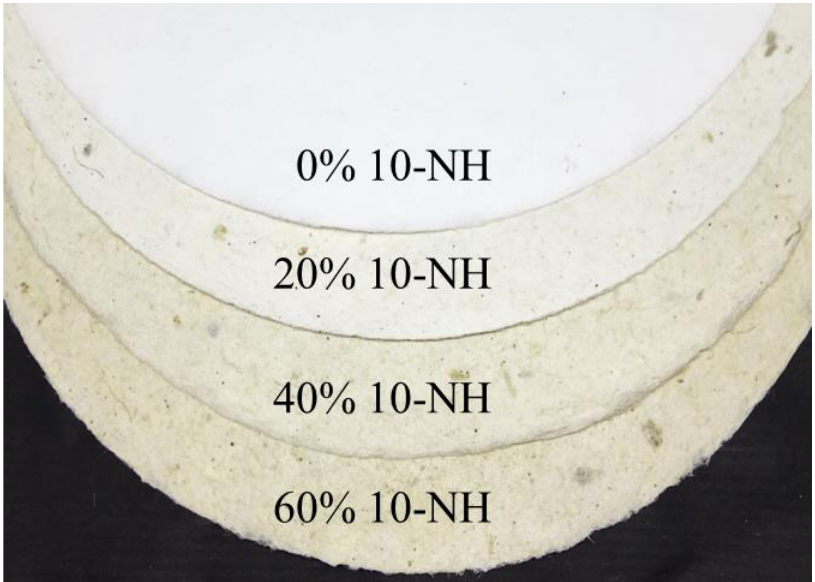
Figure 7. ( a ) Visual appearance and ( b ) FTIR spectra of Rhizoclonium pulp samples prepared using 10-N, 10-NH, and 10-NS cooking treatments in handsheets. 3.3. Characterization of Handsheets Produced from Algal Pulp Mixed with Wood Pulp The handsheets made from Rhizoclonium pulp generally exhibit weak mechanical properties compared with wood pulp. The wall structure of the wood pulp is primarily composed of microfibrils that improve the bonding and strength between the fibers. However, algal pulp lacks microfibrils, which results in the paper having low mechanical strength [9, 56]. Chao, Su and Chen [9] improved the mechanical properties of a handsheet made from Rhizoclonium pulp by mixing it with wood pulp. The results showed that the strength properties of the handsheet were improved by combining 10% Rhizoclonium pulp (20% NaOH cooking solvent) with 90% wood pulp. In order to reduce the consumption of wood pulp resources and to use Rhizoclonium pulp effectively, the wood pulp was mixed with 0%, 20%, 40%, and 60% 10-NH Rhizoclonium pulp to prepare handsheets that were analyzed for their mechanical properties, morphology, and surface roughness. The basis weights of the 5 types of handsheet were between 35.8 and 37.8 g/m 2 (Figure 8). A higher proportion of 10-NH Rhizoclonium pulp resulted in lower mechanical properties in